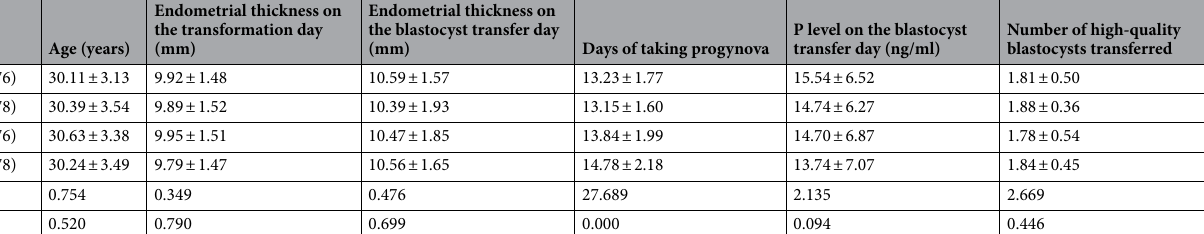
Table 3. Comparison of clinical characteristics among groups divided by serum estrogen levels on the blastocyst transfer day.